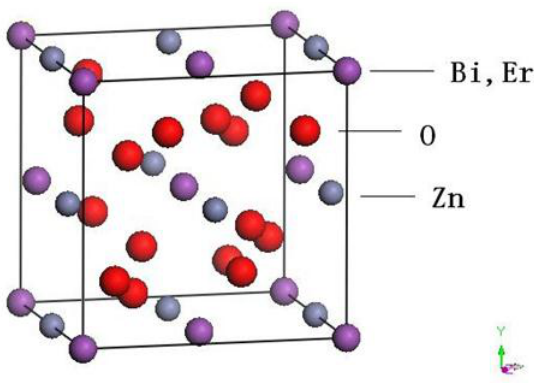
Figure 7. Atomic structure of ZnBiErO 4 . Table 1. Atomic coordinates and structural parameters of ZnBiErO 4 prepared by the solid reaction method.